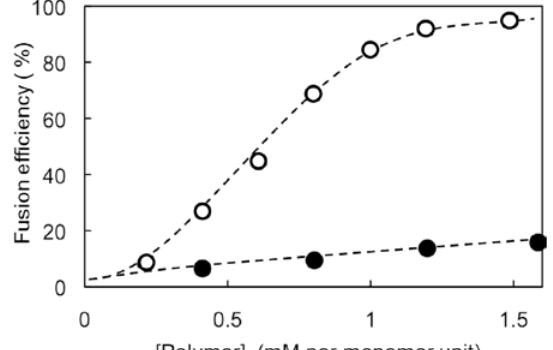
Figure 5. Dependences of polymer concentration on liposome fusion efficiency for PVSK and PVA (open and closed circles, respectively) evaluated by FRET assay. Aqueous fluorescence-labeled liposomes composed of lipids 1 and 2 (0.20 and 0.80 mM, respectively) and Rh-PE and NBD-PE (both 0.50 µ M) were mixed with unlabeled aqueous liposomes composed of 1 and 2 (both 0.50 mM) in a volume ratio of 1/9 (v/v) at pH 7.0 and 35 °C; fusion efficiency evaluated for by addition of various concentrations of a